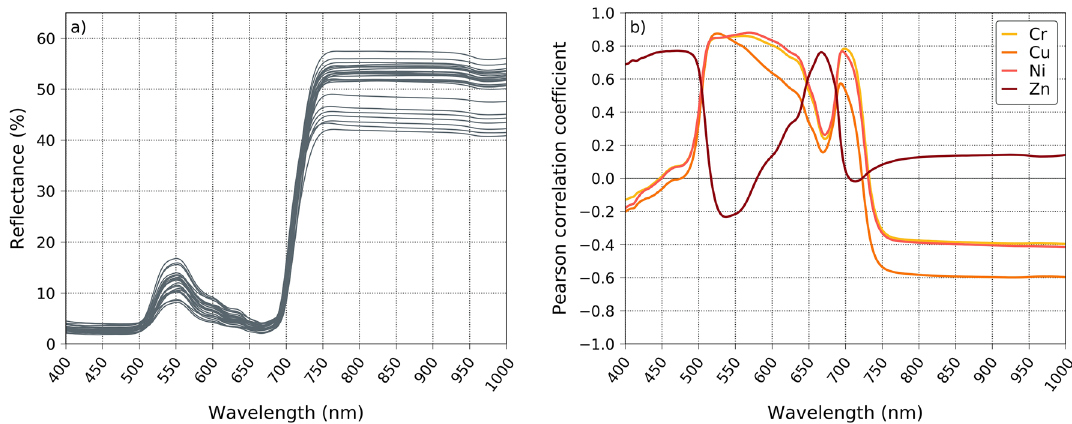
Figure 3. ( a ) Spectral signatures of the leaves sampled on the brownfield ( n = 26), in the Visible Near- Infrared domain (VNIR). These signatures were used to develop the optimized vegetation indices. ( b ) Pearson correlation coefficients ( r ) obtained between leaf reflectance measured at each VNIR wavelength and the four heavy metal contents analyzed in tion of chloroplast ultrastructure. In addition, synergistic, antagonistic and additive effects have been observed under exposure to realistic HM mixtures 30,60 . All these metals also impact plant-water relations negatively at high concentration in soils, affecting leaf turgor and causing tissue destructuring 3,17 . Additional effects on paren- chyma structure are also due to the accumulation of these metals in leaves 5,61 . Since leaf anatomy is closely linked to reflectance in the NIR, this probably explains its correlation with HM in this region. Unlike the other metals, Zn content in leaves was correlated to the blue (400–500 nm) and red (650–670 nm) regions. An increase in reflectance around 650 nm is usually attributed to leaf redding, which comes from anthocyanin synthesis 62,63 . Zn toxicity includes the alteration of photosynthetic pigments through the formation of [Zn]-chlorophyll, which—in contrast to Cu and Ni—still allows photosynthesis. There is also little evidence that Zn induces leaf redding, by enhancing anthocyanin production. This latter effect might prevail over that of other pigments in bramble, explaining the singular pattern of correlation between leaf reflectance and this metal.